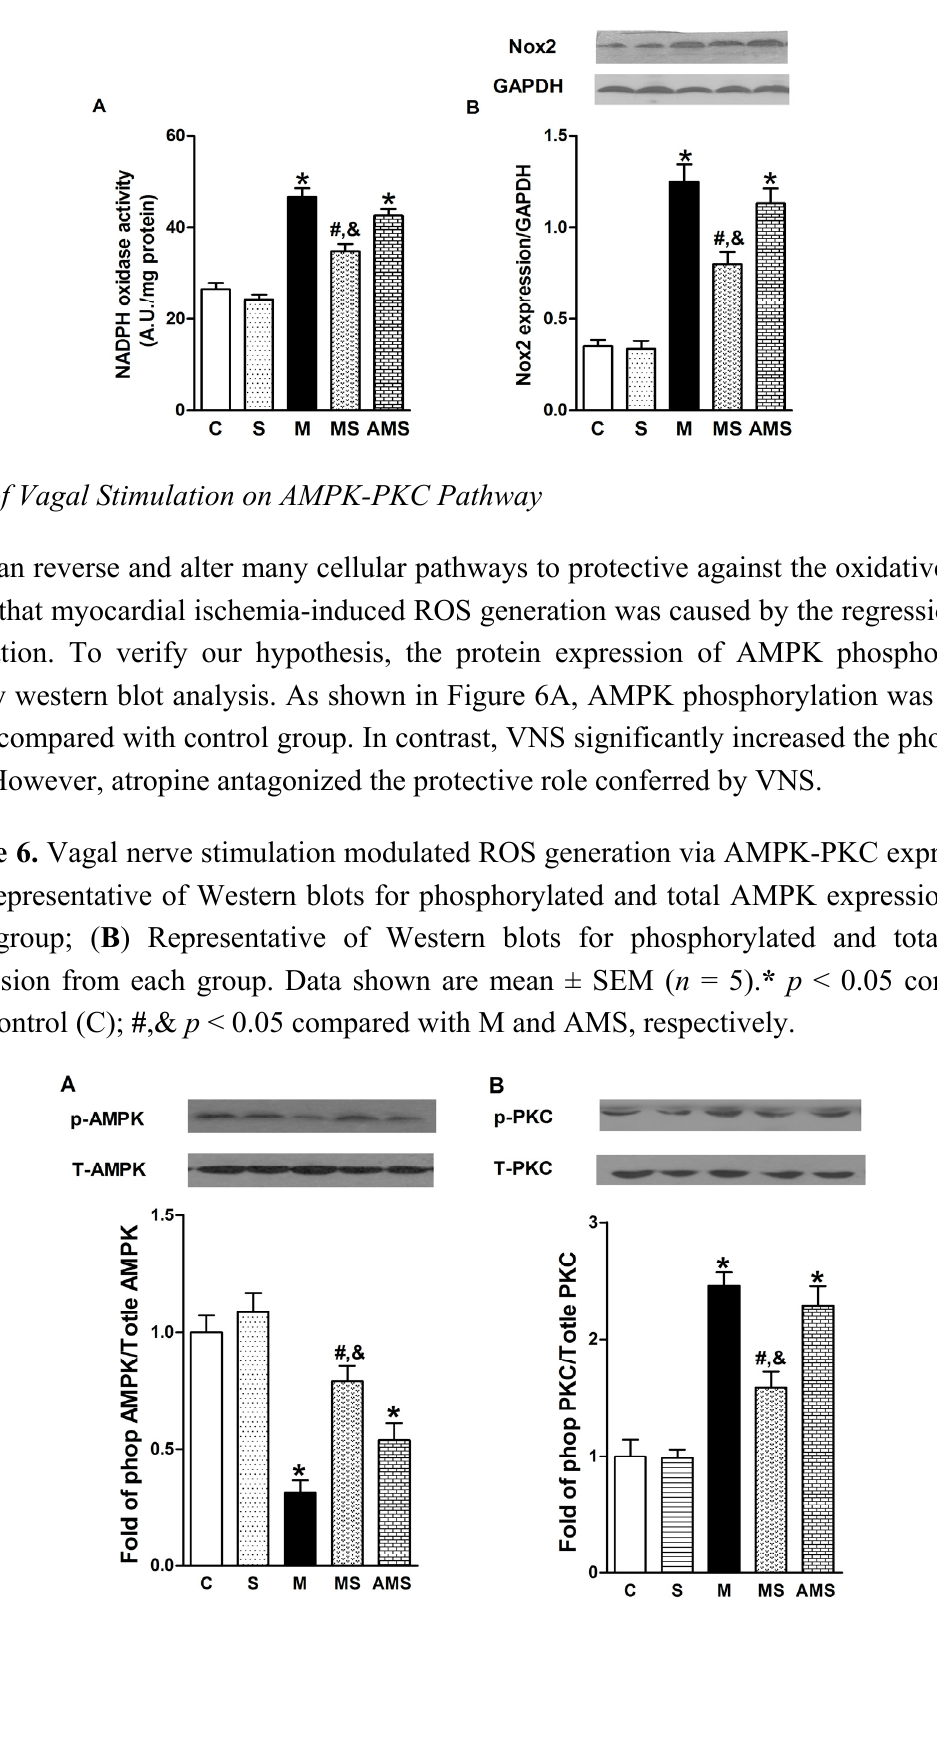
Figure 5. VNS inhibits oxidative stress in rats with AMI via Nox pathway. ( A ) Nox activity measured by lucigenin-enhanced chemiluminescence in each group; ( B ) Representative of Nox2 protein and analysis in each group. Data shown are mean ± SEM ( n = 5). * p < 0.05 compared with control (C); # ,& p < 0.05 compared with M and AMS, respectively.